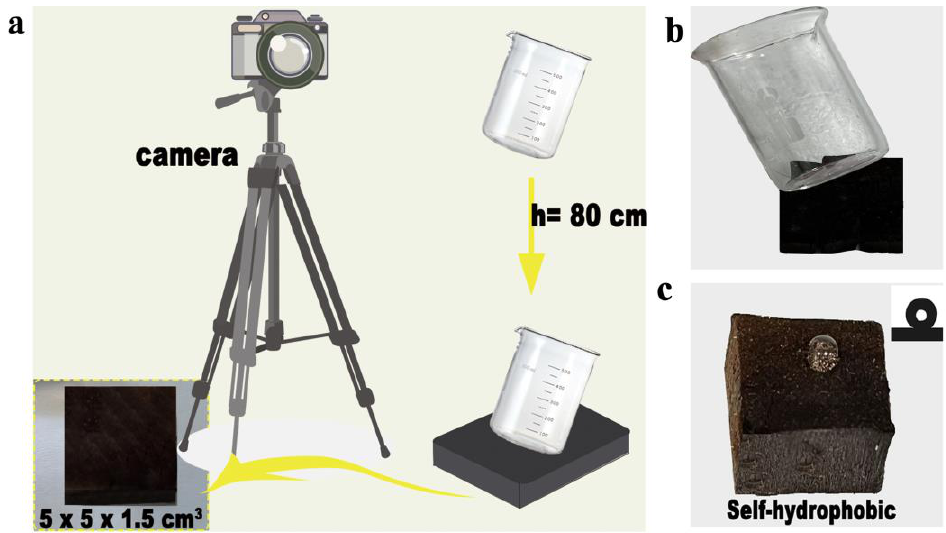
Figure 7. ( a , b ) Drop test to simulate the loading and unloading process. ( c ) Wettability of the elastic wood.